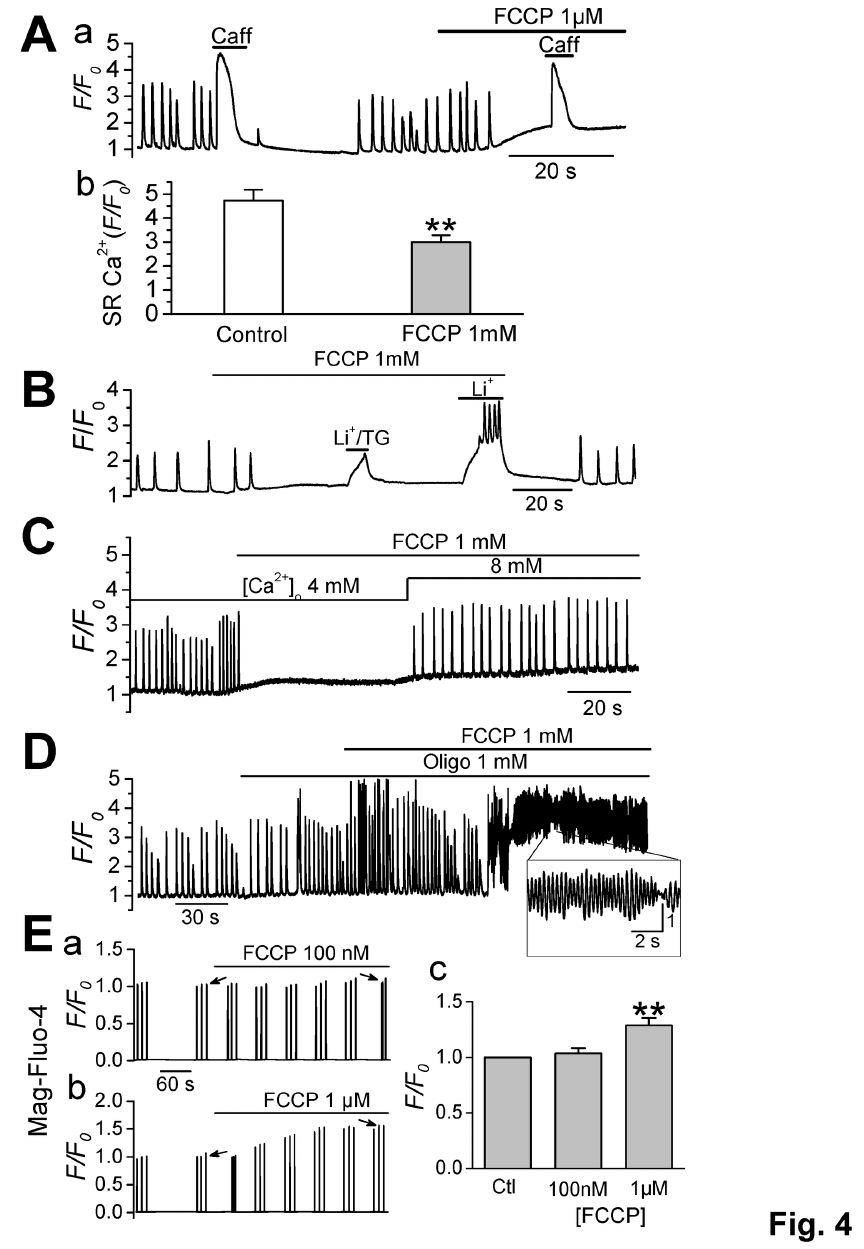
Figure 4. Elimination of SCWs by high dose FCCP is due to the reduction of SR Ca i2+ level via Ca 2+ extrusion by sNCX and less SR Ca 2+ uptake by SERCA. A . SR Ca 2+ content was assessed by rapid application of 10 mM caffeine in the absence and presence of 1µM FCCP. FCCP significantly reduced SR Ca 2+ concentration, presumably via Ca 2+ efflux by Na + -Ca 2+ exchanger (NCX) (** p < 0.01 vs. control, n = 5). B . Suppressing NCX restored SCWs in the myocytes pretreated with 1µM FCCP, while no SCWs were observed when SERCA2a was inhibited with thapsigargin (TG, 1µM). C . High-dose FCCP-inhibited CaWs were restored by elevating [Ca 2+ ] from 4 mM to 8 mM. D . Lack of CaW inhibition by high-dose FCCP (1 µM) in the presence of o Oligomycin (Oligo 1 µM). The expanded trace in the inset shows a fast Ca i2+ oscillation status. E . Mag-fluo-4 fluorescence (evaluation of reciprocal changes of [ATP] ) traces recorded in mouse ventricular myocytes treated with ( E - a ) 100 nM FCCP or ( E - b ) i 1 µM FCCP. The baseline value (i.e. before perfusion of FCCP) was normalized to 1, as indicated by the leftward-facing arrow in each panel. The F/F level at 6 min after FCCP treatment (as indicated by the rightward-facing arrow) was compared between 0 different groups. E - c . Summary data showing the intensity of the fluorescence (F/F ) recorded 6 min after the treatment (** p < 0.01 0 vs. Ctl). doi: 10.1371/journal.pone.0080574.g004 PLOS ONE |